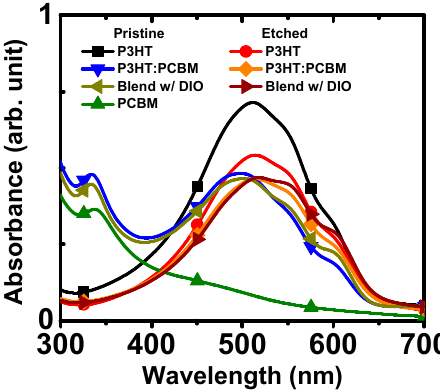
Figure 2. UV-Vis absorption of thin films of polymer and polymer blends under various conditions.